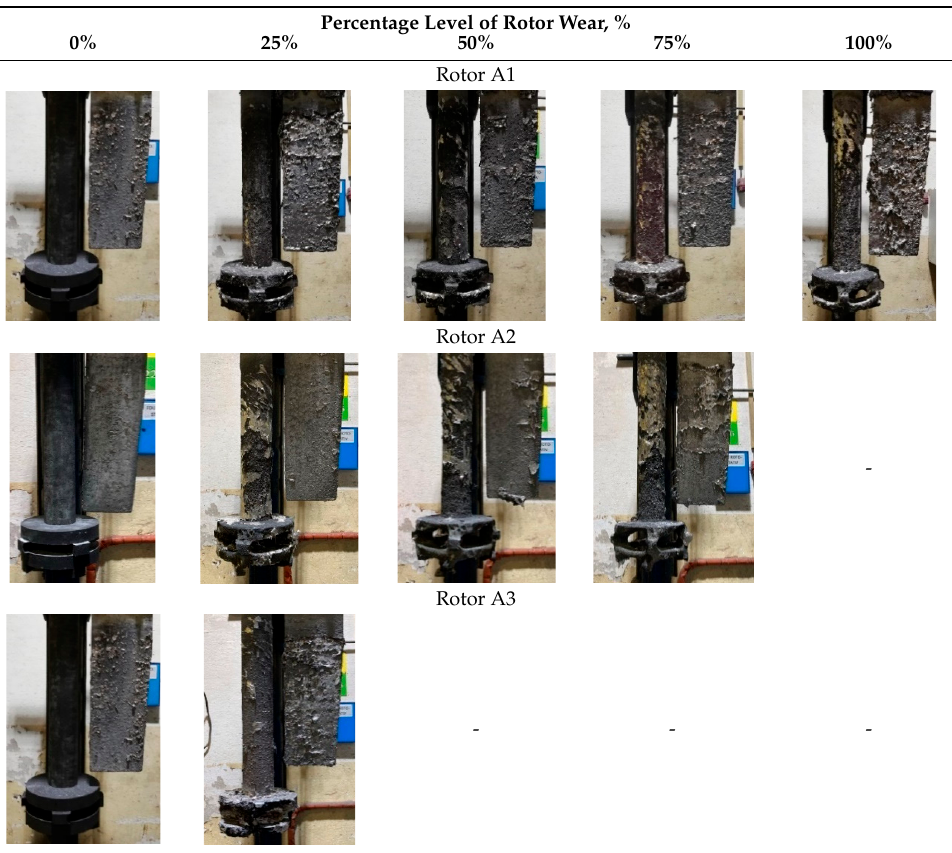
Table 5. Comparison of rotors wear profile at different stages of service life.